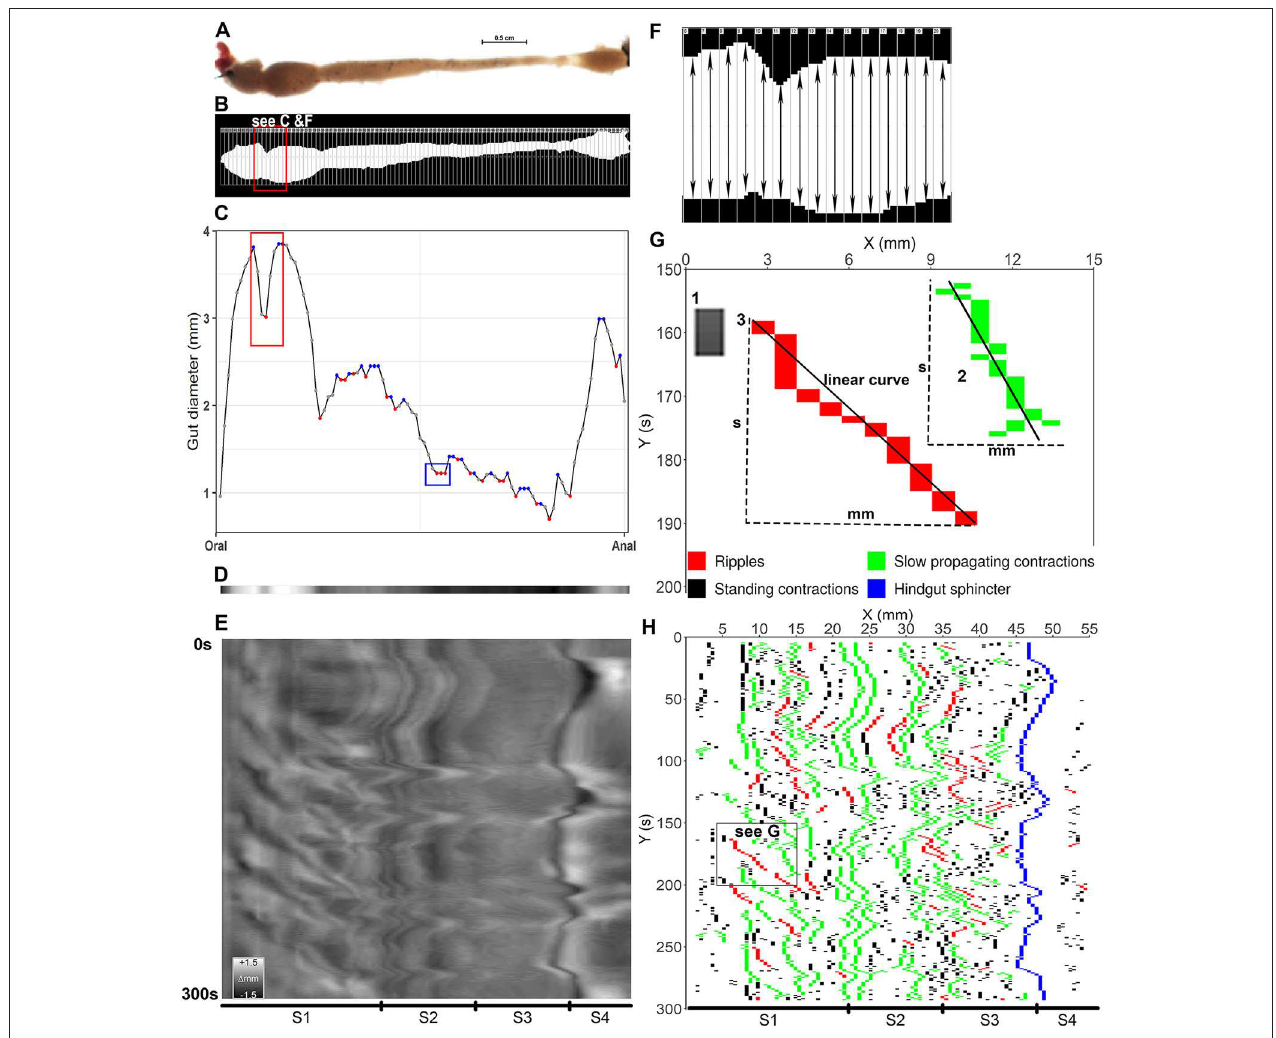
FIGURE 3 | Converting video frames to ST maps and identifying contractions. (A) a video frame shows the ballan wrasse intestine which was transferred to binary color and drawn hundreds of regions of interest (ROI) in to measure intestinal diameter at each pixel (B) . (C) diameter values at each pixel along the intestine in (B) were displayed as dots in gray, blue and red colors; and the curve that connects the dots shows the dynamic change of the diameters from the anterior (oral) to posterior (anal) intestine. The blue dots show the local maximum values and the red dots for the local minima. The red rectangular shape in panel (C) shows the change of diameter values of the intestinal section in (F) where the red dot shows the smallest value of a ROI compared to those (gray dots) of the adjacent ROIs. In blue rectangular shape in panel (C) the first red dot was defined as a local minimum and the two next dots had a similar diameter to the first red dot, hence three of them were defined as contractions. (D) a gray band was constructed from the values of diameter in (C) as the lowest in black and the highest in white. (E) all frames in a trimmed 300s video ( Supplementary Video 2 ) were converted to gray bands to build up a gray-scale ST map on which the vertical direction showing the time and the horizontal direction showing the 4 segments (S1–S4) of intestine; the calibration bar shows changes in diameter as grayscale ( 1 mm). (F) , detail of an intestinal section showing a contraction; each rectangle with a number on the left corner was a ROI with its own ID (RoiID) to measure the distance between upper and lower edge of the white area inside (intestinal diameter). (G) , a successful contraction as an object on the binary map, was identified as either an isolated rectangle (1) or a cluster of rectangles connecting each other (2,3). Width (mm) represents for propagating distance, height (s) for duration, and slope and r-squared of the linear curves are used to identify contraction type, propagating direction and velocity. (1) A standing contraction; (2) A slow propagating contraction moves anterograde direction; 3, a ripple contraction propagates anterograde direction. (H) , a binary ST map was plotted from local minima selected on each frame (see C ) shows tempo-spatial distribution of three contraction types along the four segments (S1–S4, Segments 1–4) of the ballan wrasse intestine.